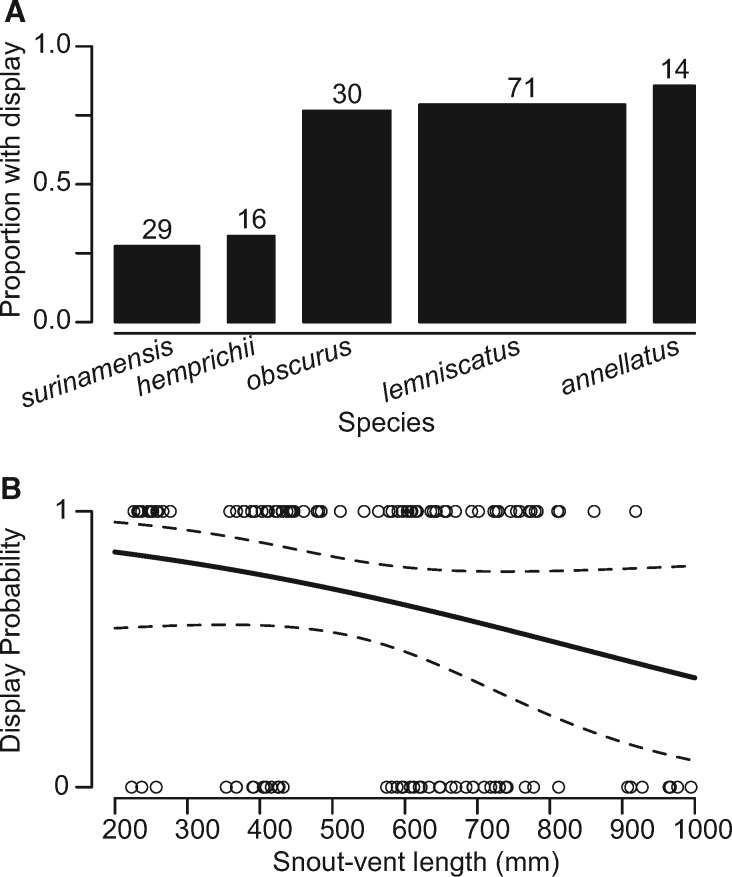
Not all individuals performed a thrashing display in response to all cues. Display probability depended most strongly upon (A) species identity (binomial GLMM: F4,22= 5.907, P = 0.002) and (B) body size as measured by SVL (F1,22= 5.732, P = 0.026). Fitted effect of SVL is predicted from a model that includes collection ID as a random factor, as all individuals were tested more than once. Width of bars and numbers above represent the number of individuals examined in each species.